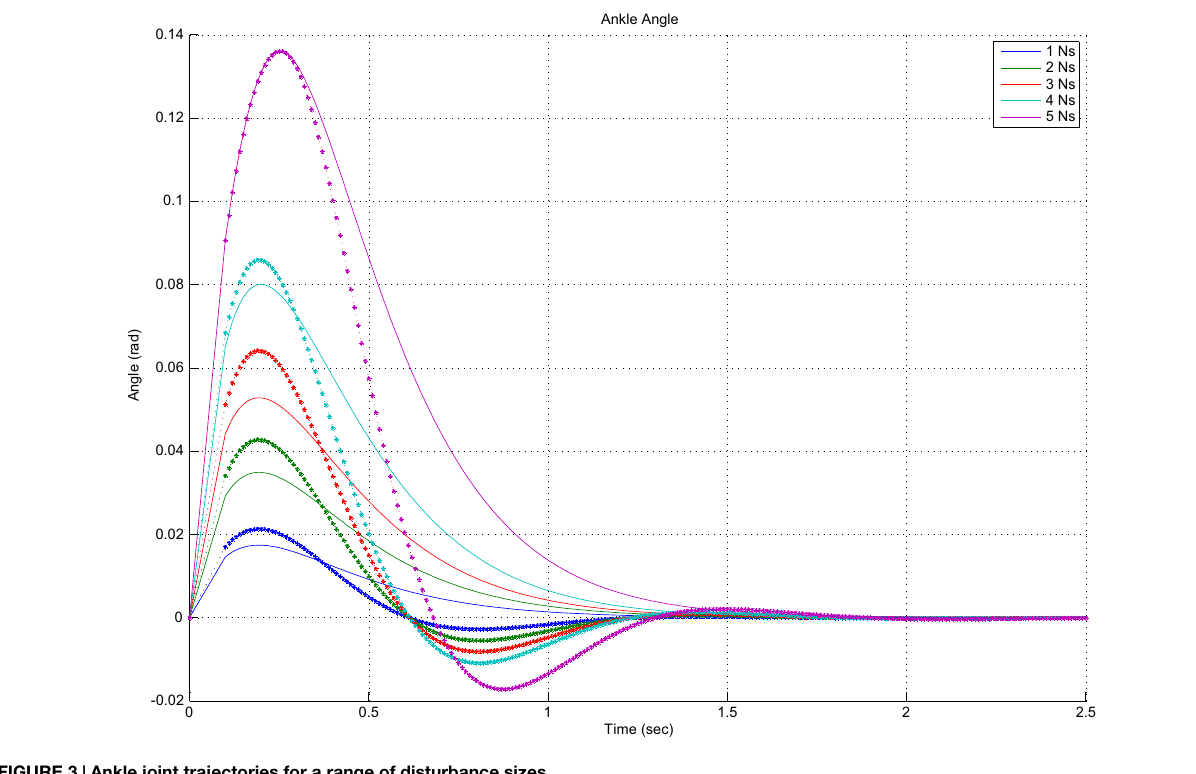
FIGURE 3 | Ankle joint trajectories for a range of disturbance sizes .